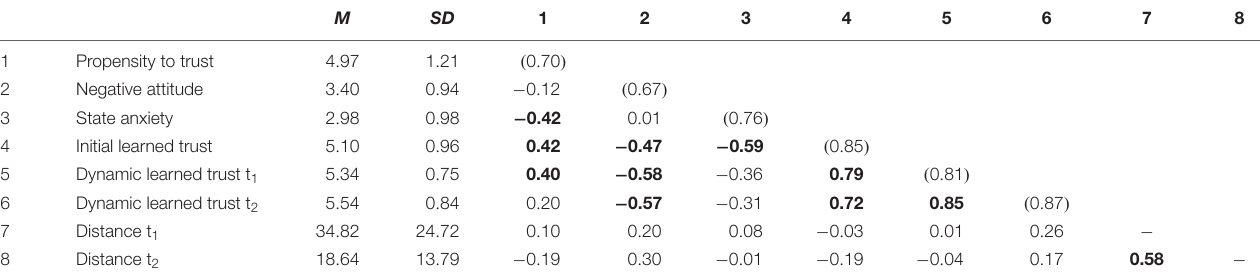
TABLE 2 | Means, standard deviations, correlations, and reliabilities of the included variables.